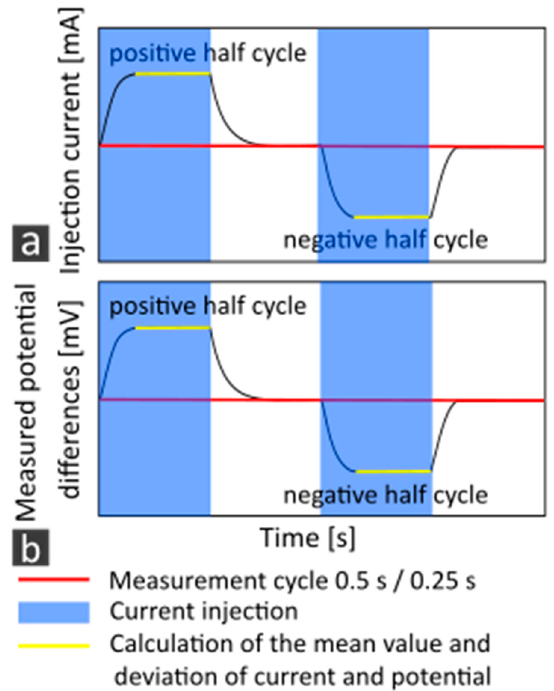
Figure 3. Sketch of a geoelectric measurement cycle, showing ( a ) the strength of the injected current and ( b ) the measured potential differences with time within the time window of two half cycles. The red line describes the full length of either 0.5 or 0.25 s used for the measurements. The blue box highlights the time interval of current injection. The yellow line shows the interval for the calculation of the mean measured value of current and potential, from which the standard deviation is given, defining the measurement noise.